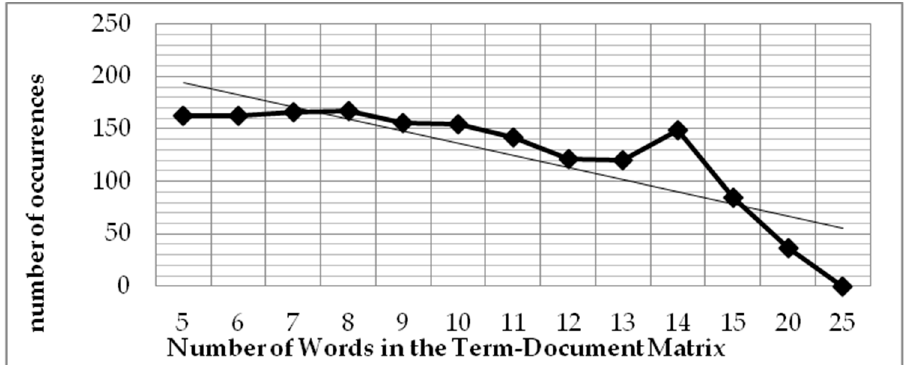
Figure 7. The number of true positive results using Learning Vector Quantization.